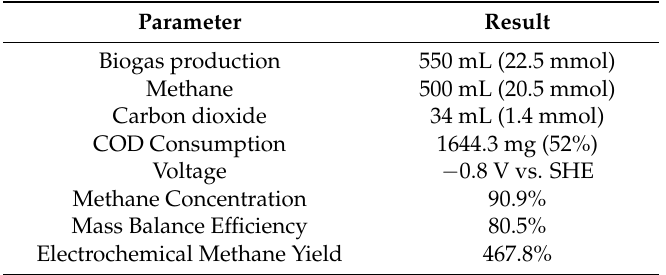
Table 1. Results of 1-week biomethane production